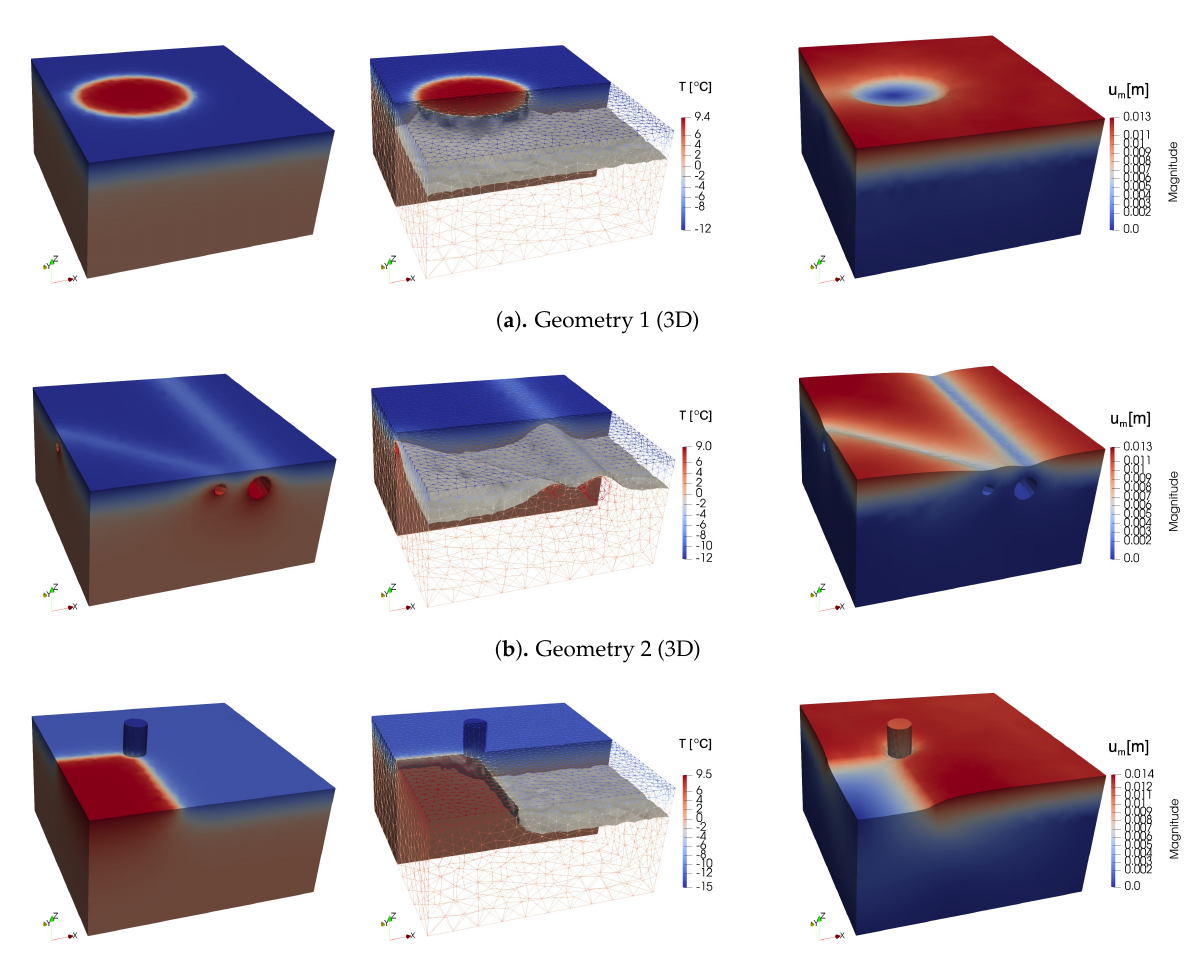
Figure 13. Test 2 for a three-dimensional problem. Temperature, temperature clip x 2 = L y /2 m with the phase change interface, and displacement fields at the final time (from left to